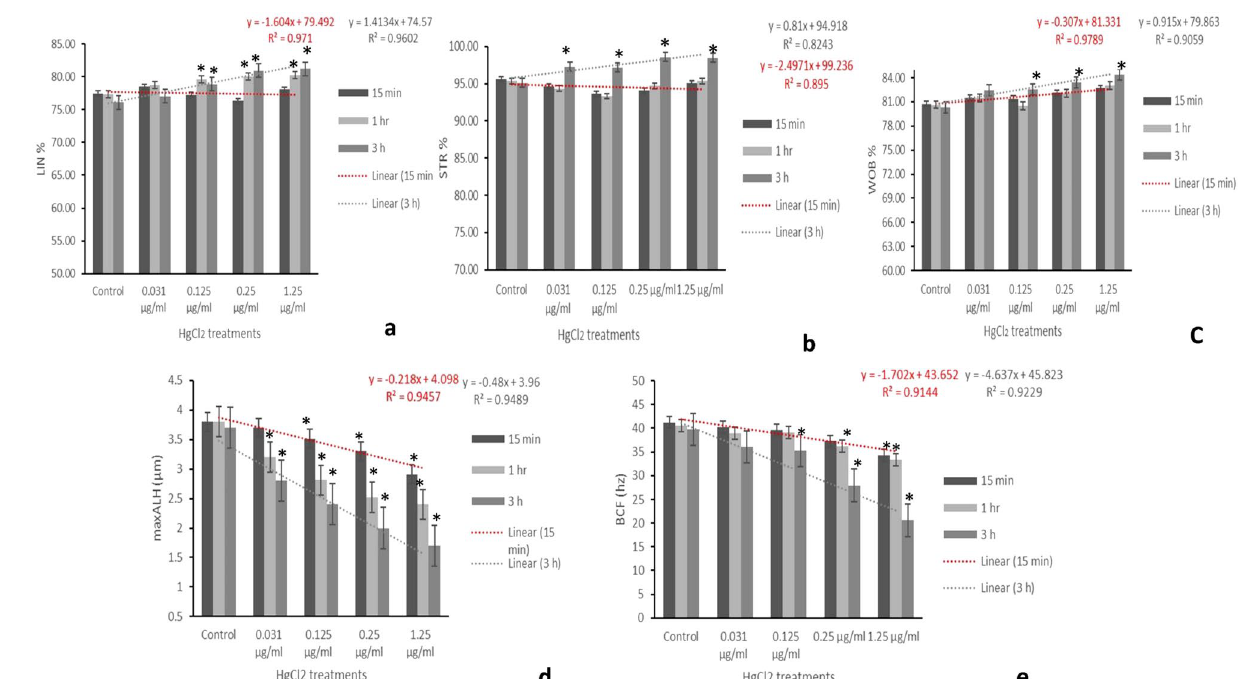
Figure 2. The relationship between different concentrations of HgCl 2 and computer-assisted semen analysis (CASA) kinematic parameters for per cent linearity (LIN; ( a )), per cent straightness (STR: ( b )), per cent WOB ( c ), maximum amplitude of head lateral displacement (maxALH; µm; ( d )), and beat cross frequency (BCF; hz; ( e )). Linear regression lines are shown along with the coefficients of determination ( R 2 ) for 15 min and 3 h. Each data point represents the mean ± SE value of repeated measurements from six male